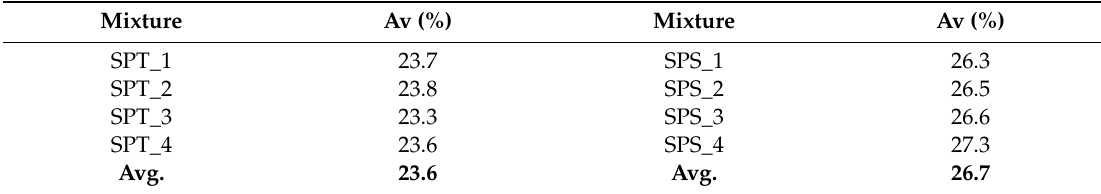
Table 3. Air voids content.